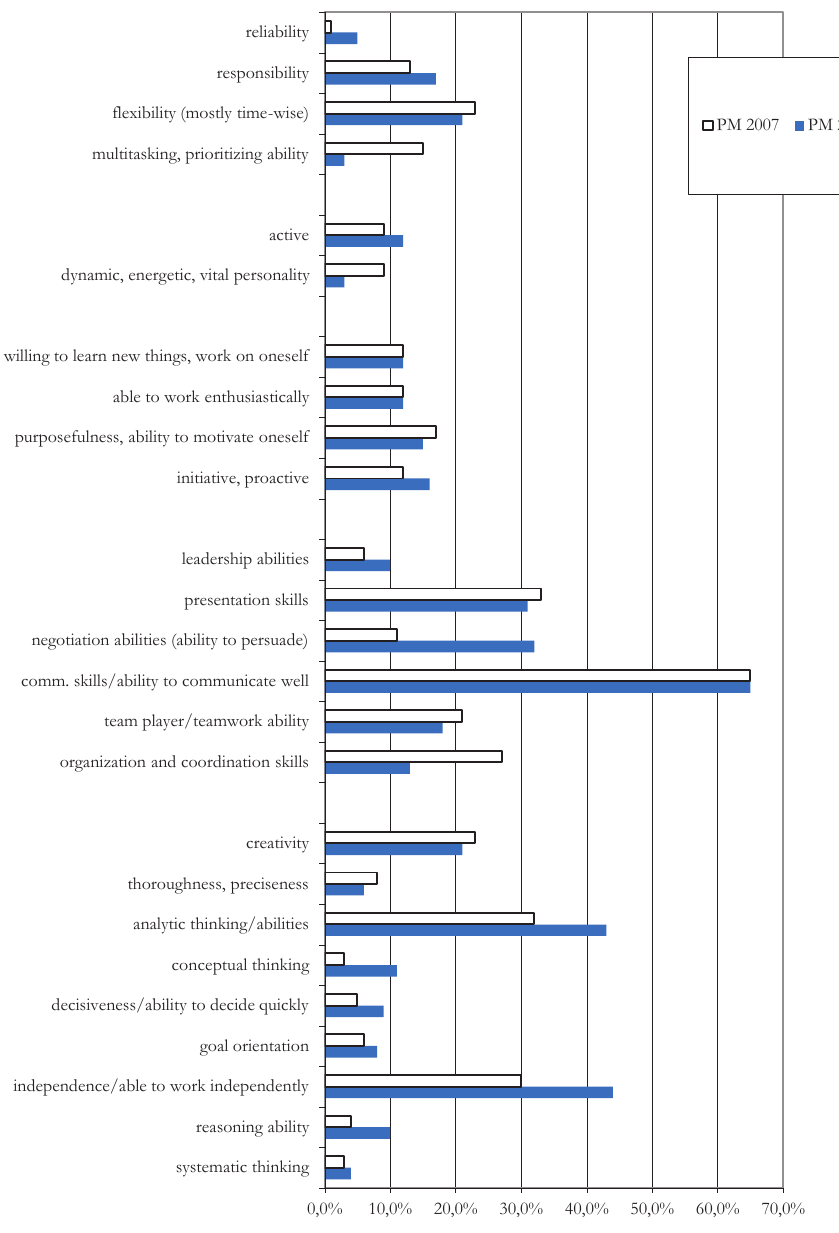
Fig. 1 - Comparison of relative frequency of psychological requirements in 2007 and 2014. Source: Independent